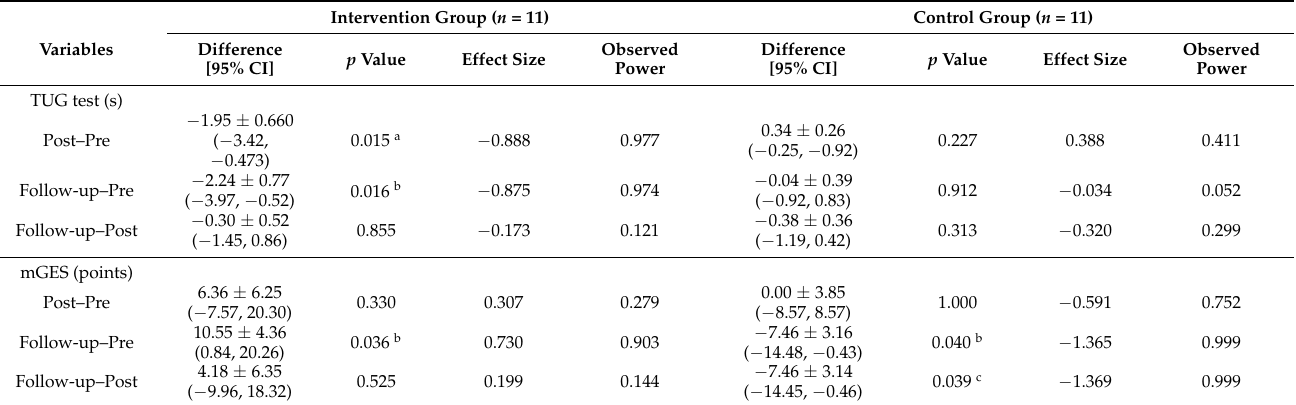
Table 3. Difference for the outcome measures between the three